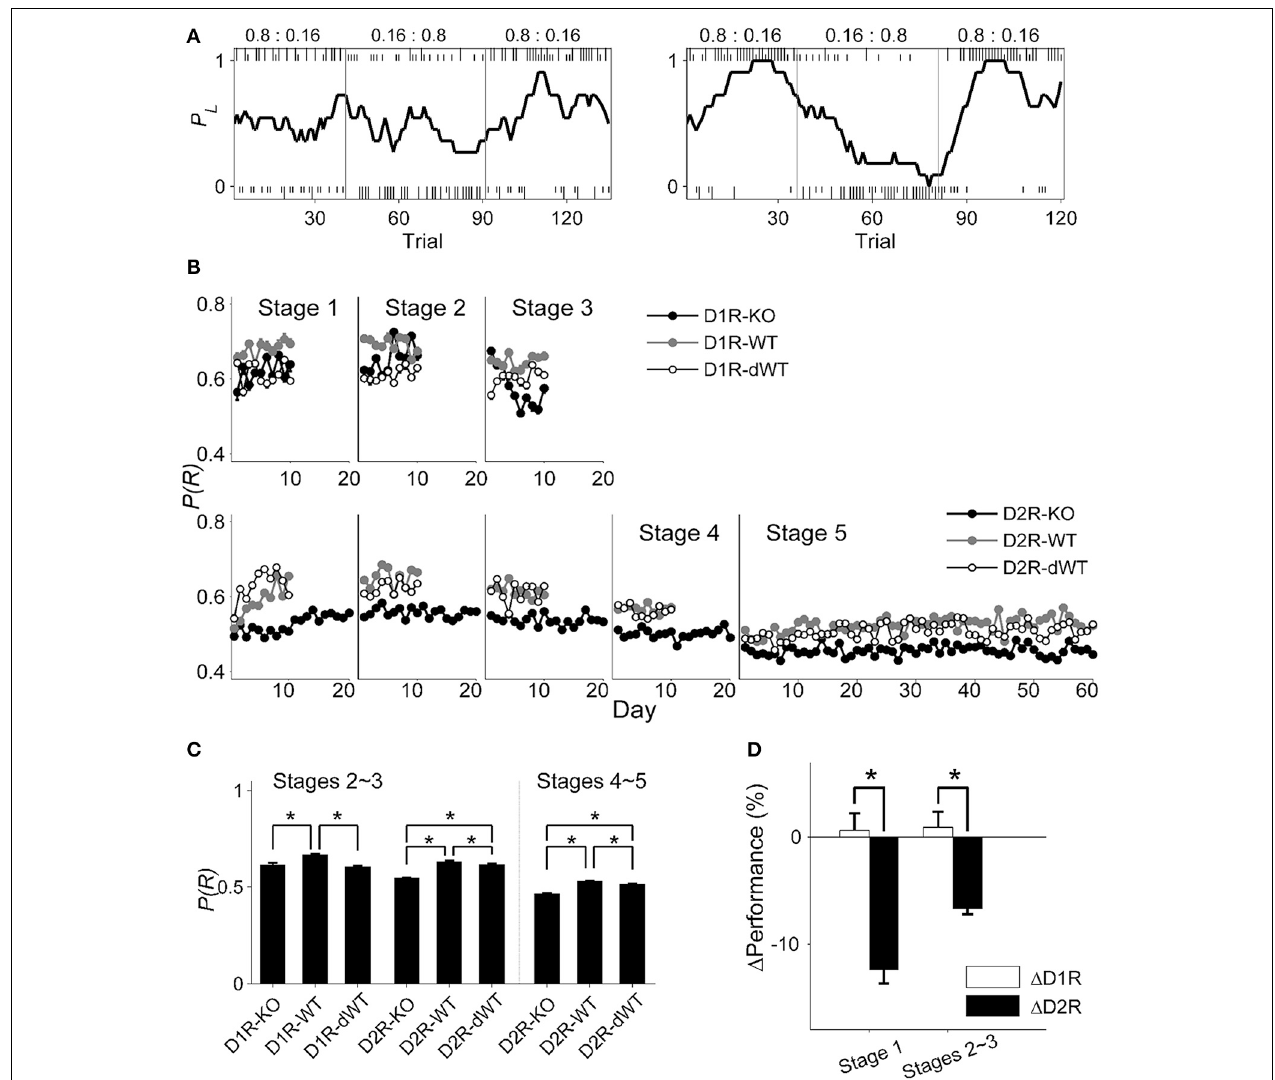
(B) The proportion of rewarded choices [P(R)] is shown for each daily session for each experimental group. (C) Behavioral performance data (mean ± s.e.m. across animals) were pooled across days for stages 2–3 and 4–5. (D) Relative performance (mean ± s.e.m. across daily sessions) is shown for stages 1 and 2–3. Asterisks, significant difference [ (C) , One-Way ANOVA followed by Bonferroni post-hoc tests; (D) , t -test, p < 0 .